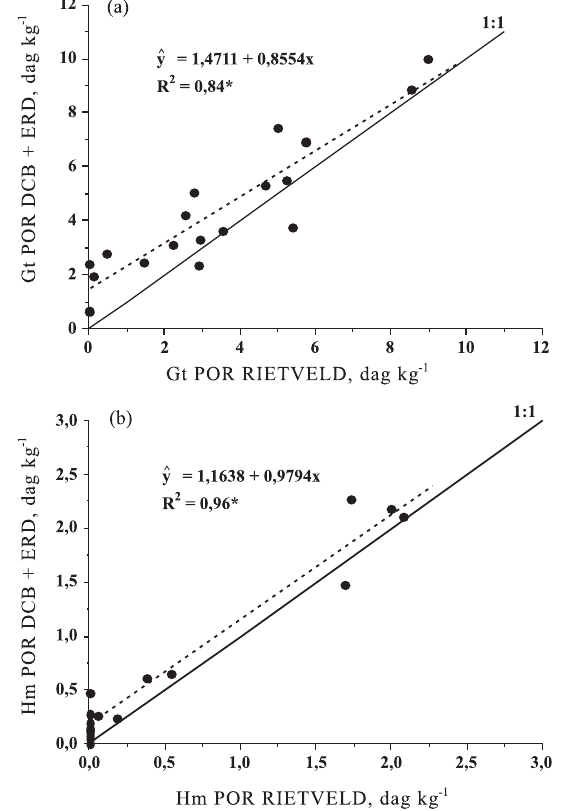
Figura 3. Relação entre os teores de óxidos de ferro obtidos por DRX e análise conjunta de ERD e DCB em amostras de argila. A linha descontínua representa a curva de ajuste linear, e a contínua, a relação 1:1. Gt: goethita; Hm: